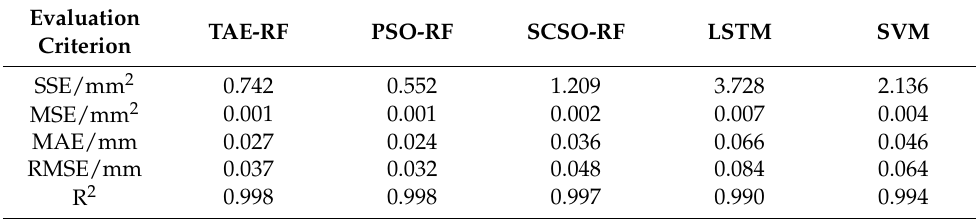
Table 2. Fitting accuracy of five models in the training